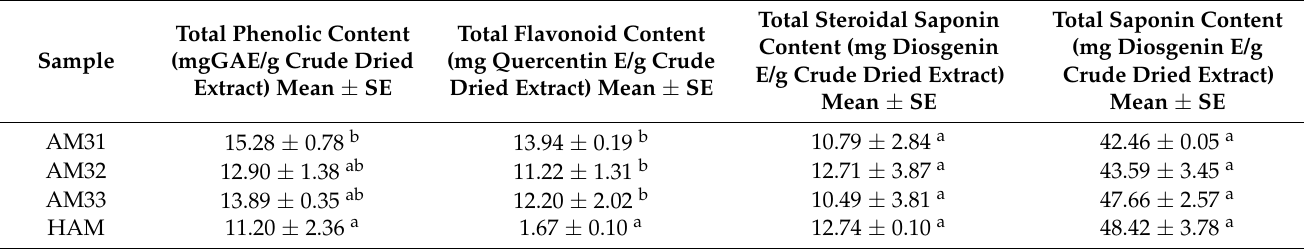
Table 3. Total phenolic, flavonoid and saponin content in crude dried shoot extracts from three A. marmorata clonal